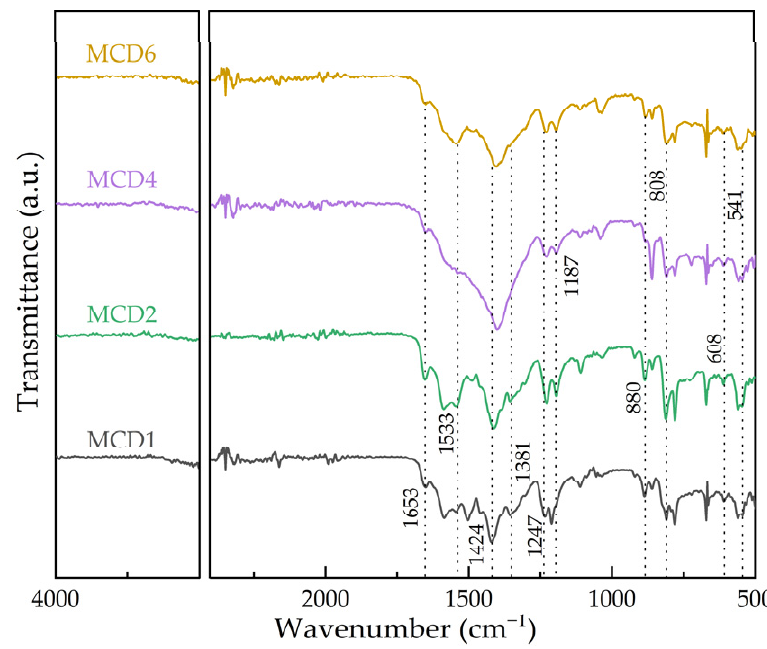
Figure 5. FTIR curves of MCDx catalysts.